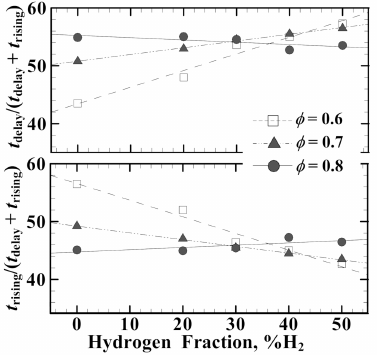
Figure 9. Occupy ratio of t delay (top) and t rising (bottom) in the combustion process of lean CH 4 /air mixtures under different